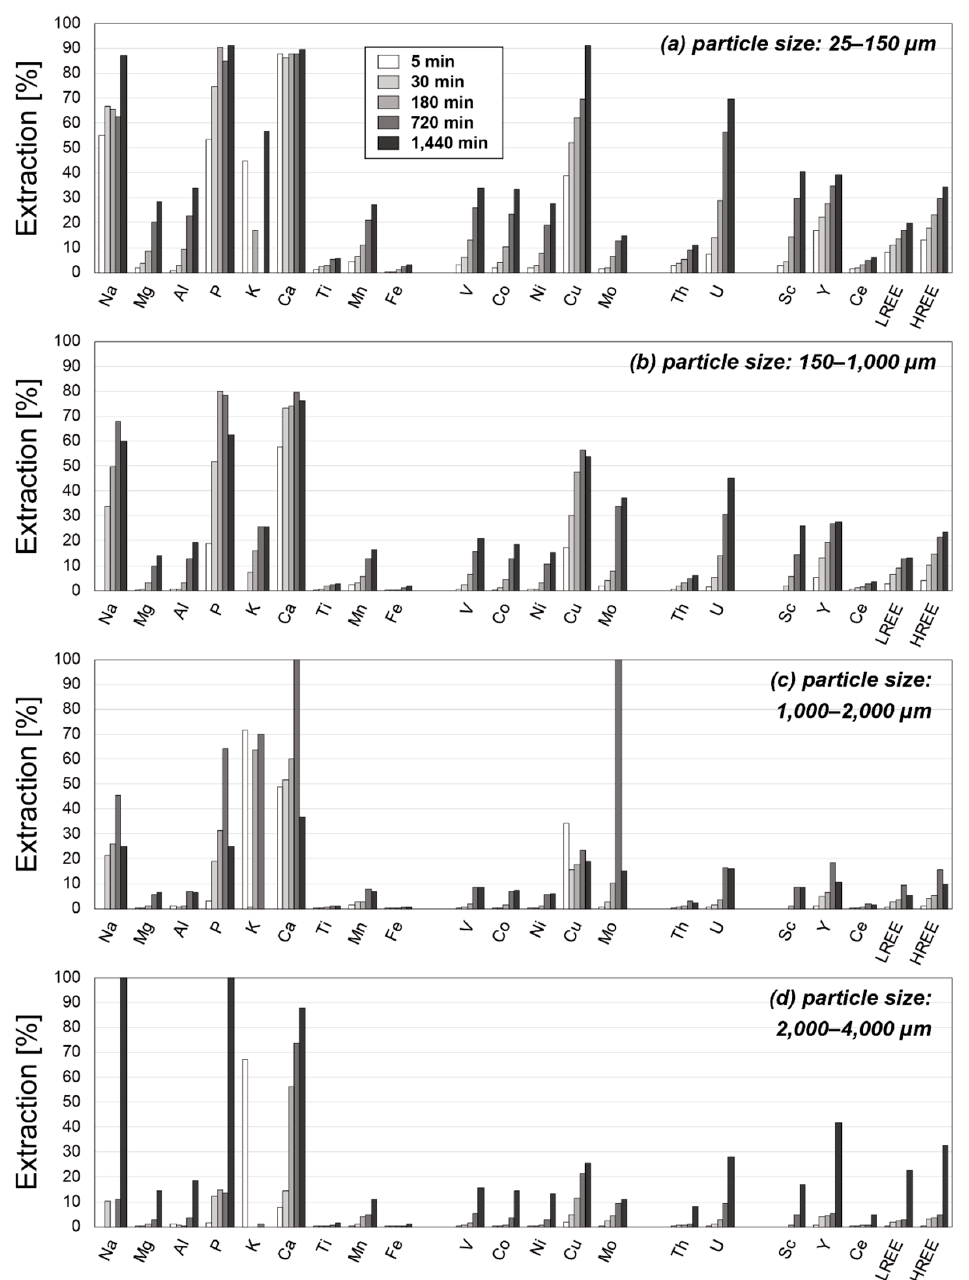
Figure 3. Extraction percentages of major elements, valuable metals, radioactive elements, and REE from the Kunimiyama umber as a function of time using hydrochloric acid as the leachate. Experiments with the particle size of ( a ) 25–150 μ m, ( b ) 150–1000 μ m, ( c ) 1000–2000 μ m, and ( d ) 2000–4000 μ m.